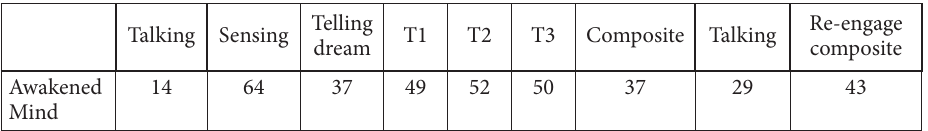
Table 5. Subject 5 – percent compliance with awakened mind at demand level 5 (source: created by author) Telling Talking Sensing dream